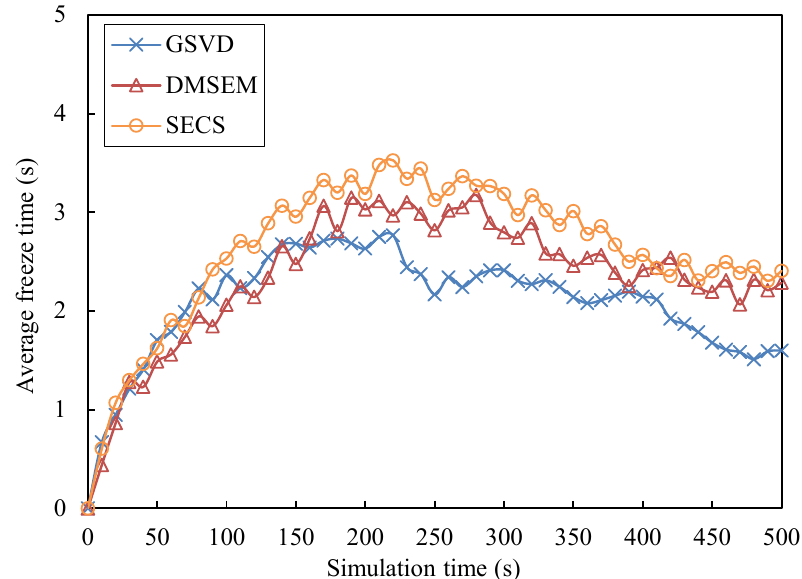
Figure 9. Average freeze time against simulation